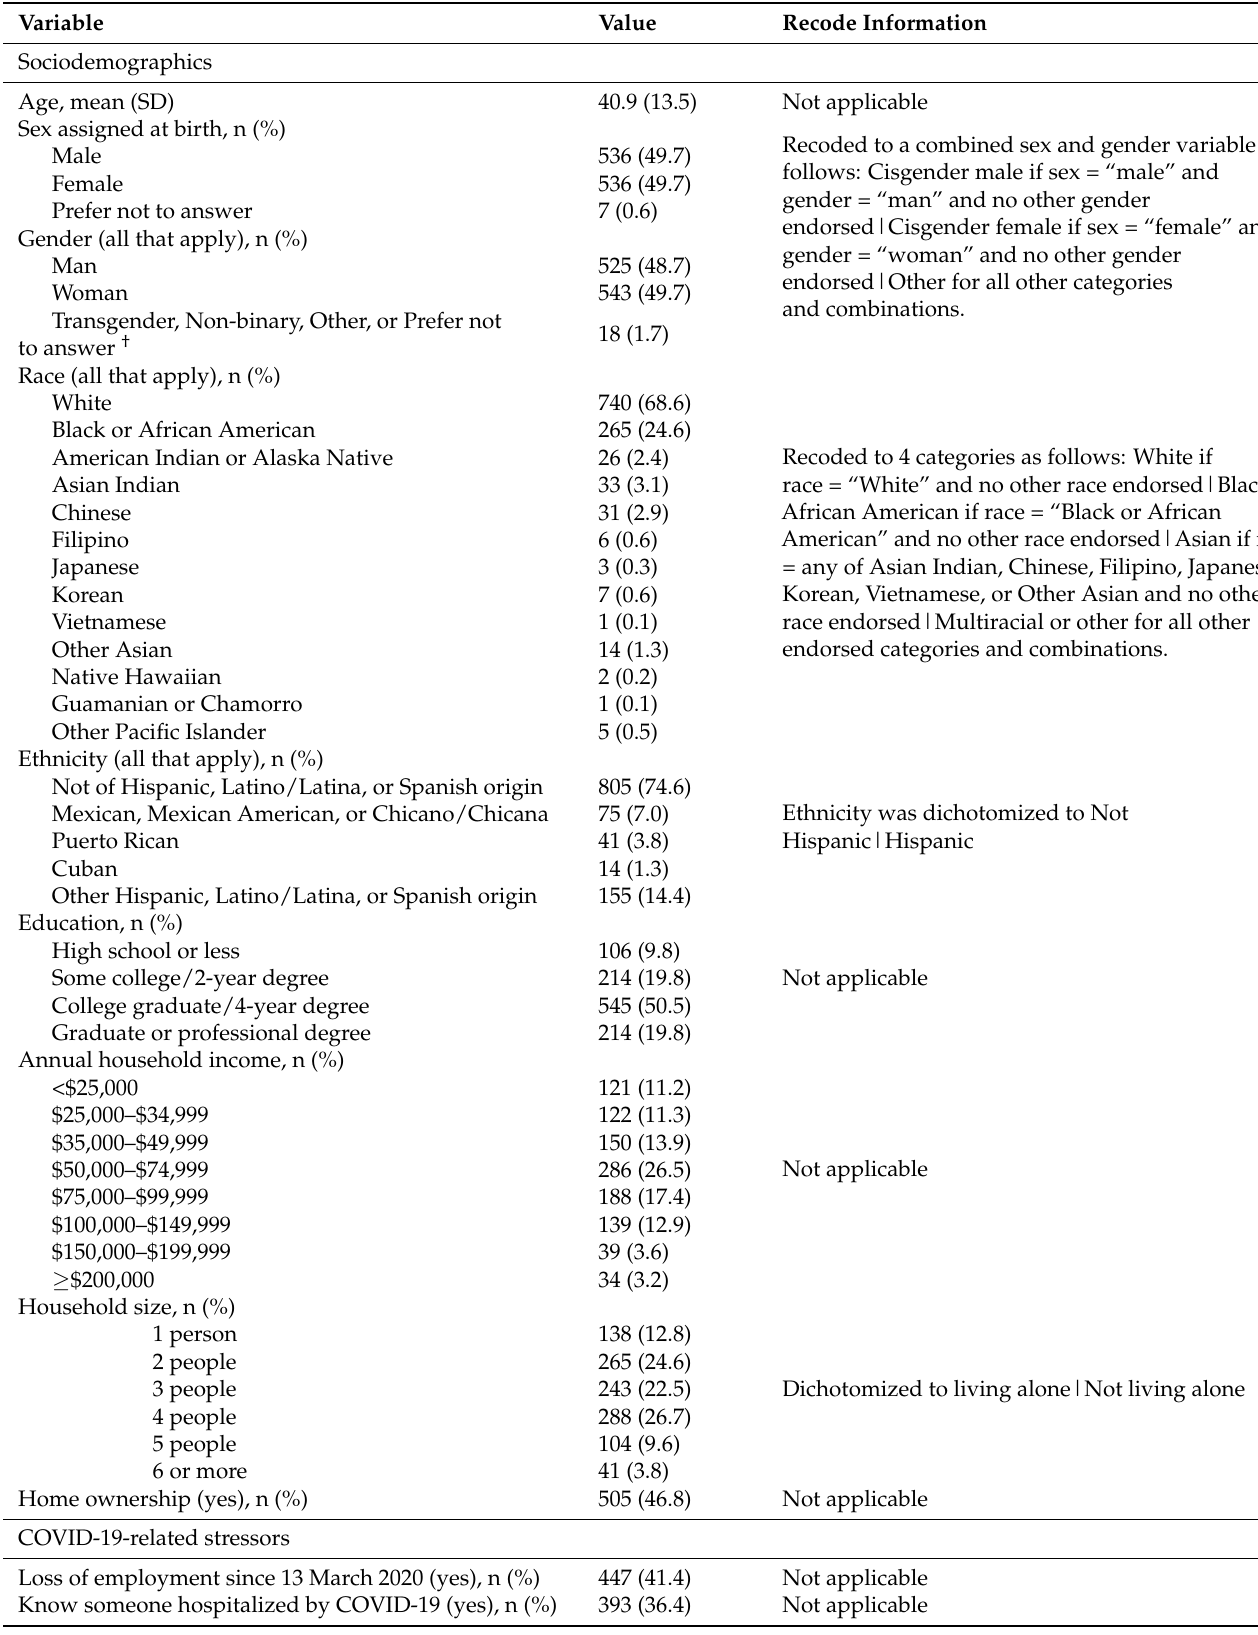
Table 1. Participant characteristics (N =